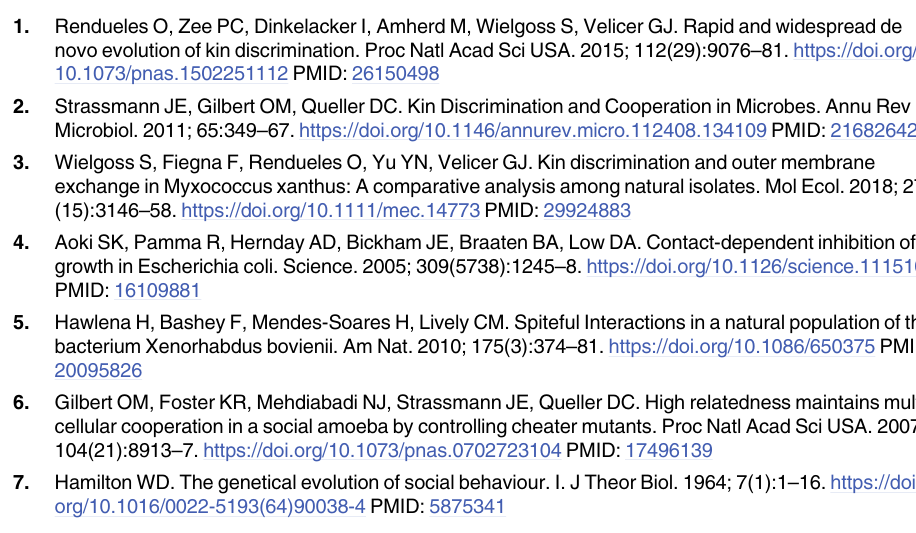
S3 Fig. Monoculture spore production values of a subset of natural isolates. Viable spore production of A23, A47, A96, their respective rifampicin-resistant variants and kanamycin- resistant traA mutants, and all other isolates mixed with A23, A47 or A96 during co-develop- ment (Fig 8). y- axis values show the log-transformed spore production of each isolate indicated on the x axis. Bars are colored either orange or grey to indicated predicted TraA compatibility. Error bars are 95% confidence intervals, n = 3